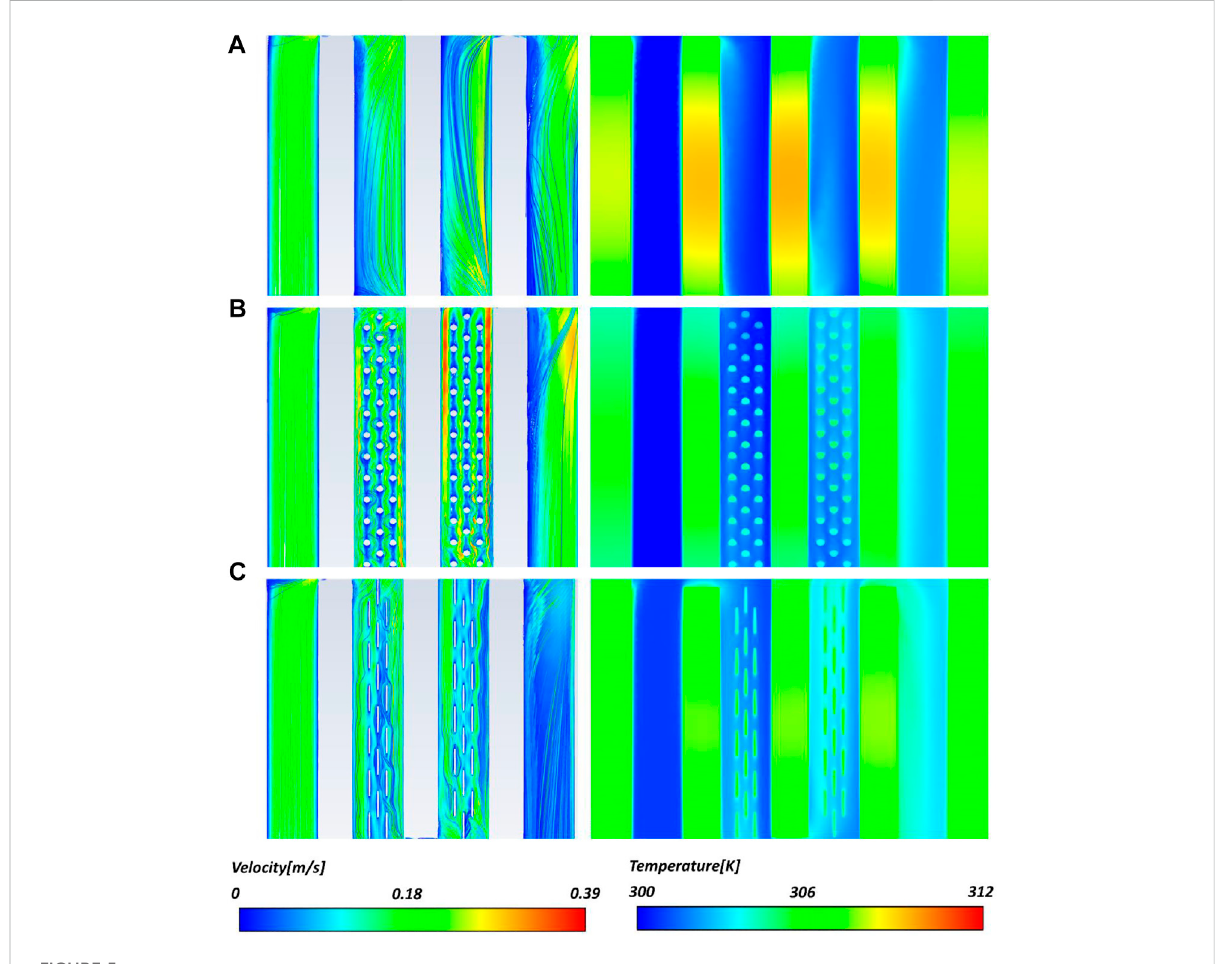
Comparison of velocity traces and temperature contours of different central fi ns at the same scale (A) without fi ns (B) bar fi ns (C) plate fi